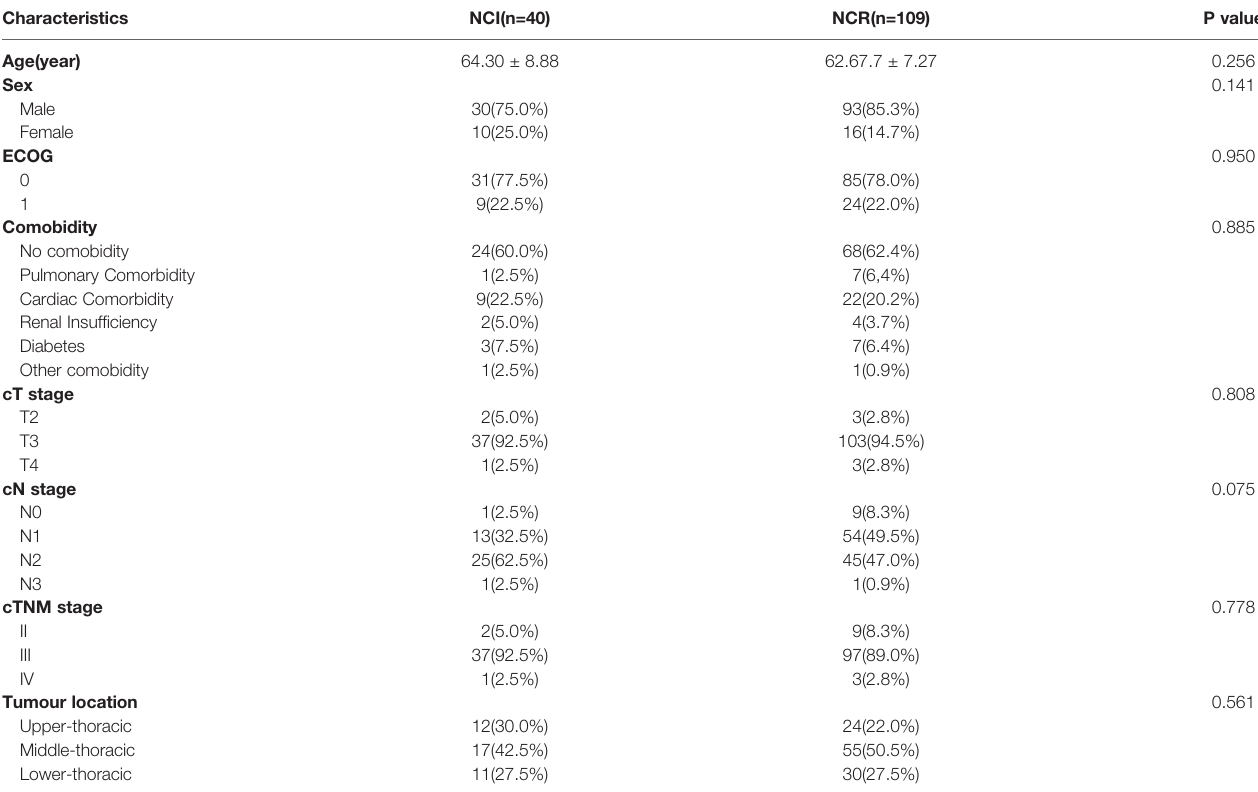
TABLE 1 | The characteristics of two cohorts.